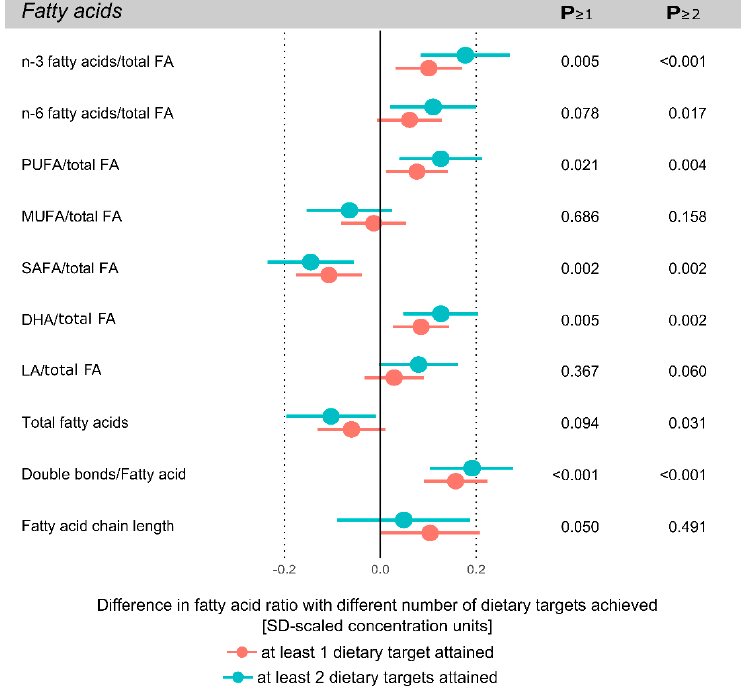
Figure 1. Differences in circulating serum fatty acids between achieving the dietary targets com- pared to achieving none of the dietary targets. Effect estimates are standard deviation scaled dif- ferences between achieving zero dietary targets with respect to achieving ≥ 1 (red) or ≥ 2 (blue) of the targets. Error bars indicate 95% confidence intervals. Metabolic measures are from pooled analyses across the six time points; n-3 fatty acids/total FA denotes the ratio of omega-3 fatty acids to total fatty acids; PUFA, polyunsaturated fatty acids; MUFA, monounsaturated fatty acids; SAFA, saturated fatty acids; DHA, docosahexaenoic acid; LA, linoleic acid.